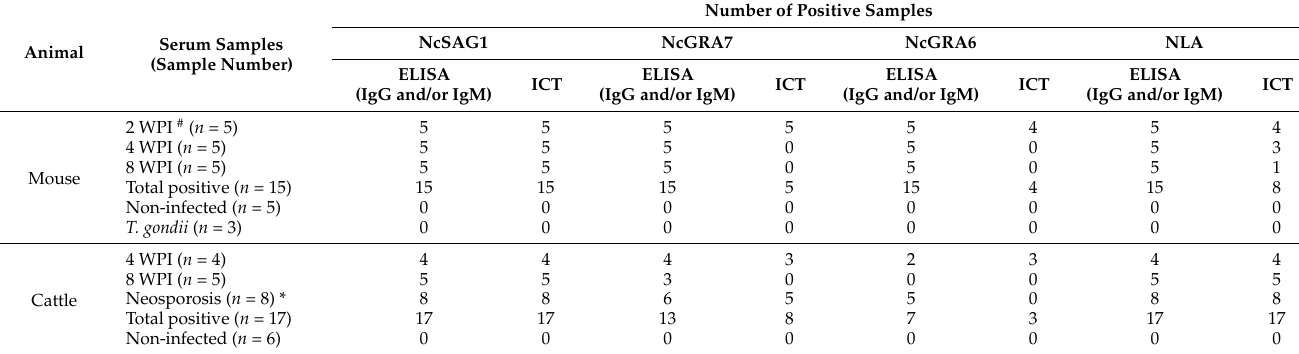
WPI # ; week post-infection. Neosporosis * refers to control-positive samples obtained from the field cattle that were confirmed via immunohistochemistry (IHC) for antigen, and indirect fluorescence antibody test (IFAT) for antibody